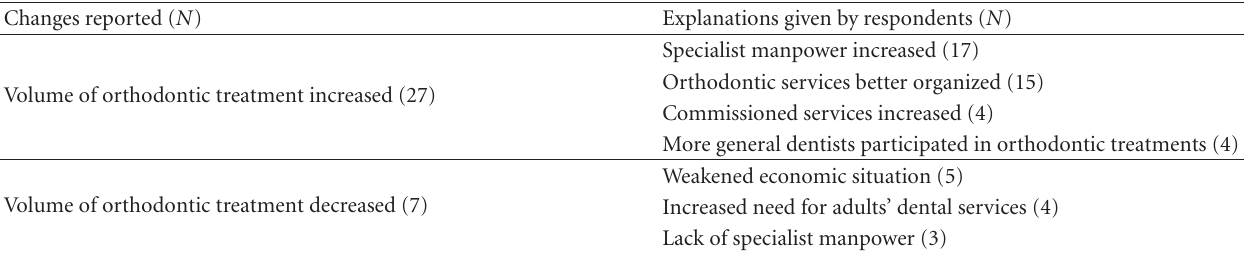
Table 4: Changes in the volume of orthodontic services during the previous five years reported by local chief dental o ffi cers ( N = 34).